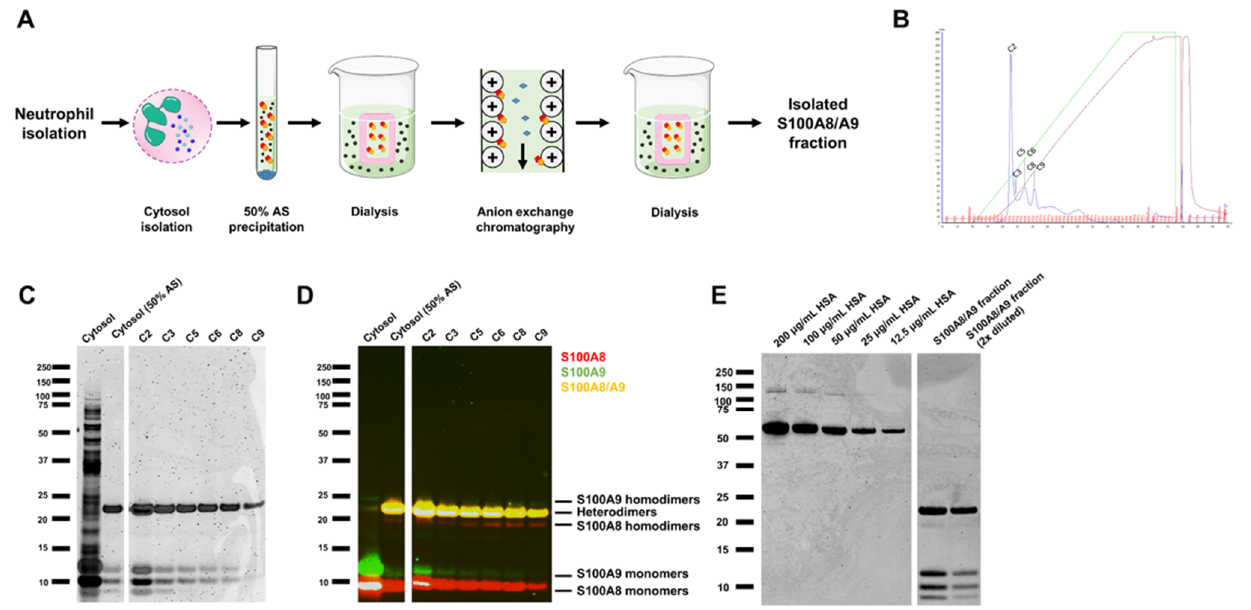
Figure 3. S100A8/A9 purification of the cytoplasm of neutrophils. ( A ) Schematic overview of the purification process of S100A8/A9 from neutrophil cytosol. ( B ) The cytoplasmic fraction of neutrophils was isolated followed by 50% ammonium sulfate (AS) precipitation and anion-exchange chromatography (AEX). Indicated are the different peaks that were isolated (C2–C9). ( C ) Coomassie Brilliant Blue staining and ( D ) Western blot of isolated peak fractions, identifying S100A8 (red) and S100A9 (green) to be presented as mostly heterodimers and monomers. ( E ) Coomassie Brilliant Blue staining with a human serum albumin (HSA) calibration curve that was used to calculate the concentration of S100A8 and A9 heterodimers and monomers in the S100A8/A9 fraction used for functional experiments.